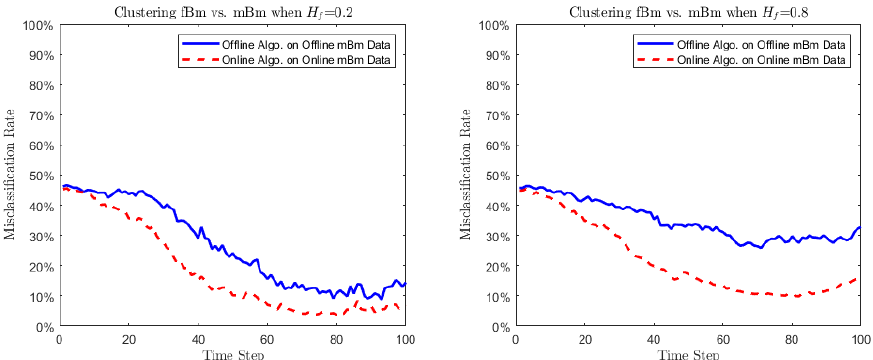
Figure 3. The clustering performance using fBm with H f and mBm with H ( • ) given in Equation (74): H ( t ) = H f + 0.1 · sin ( π t /100 ) with t = 0,1, . . . ,100. The left graph is the case where H f = 0.2, and the right graph is the case where H f = 0.8. Both graphs illustrate the misclassification rates output by ( i ) offline algorithm on offline dataset (solid line) and ( ii ) online algorithm on online dataset (dashed line). Both algorithms are performed based on the log ∗ - transformed covariance-based dissimilarity